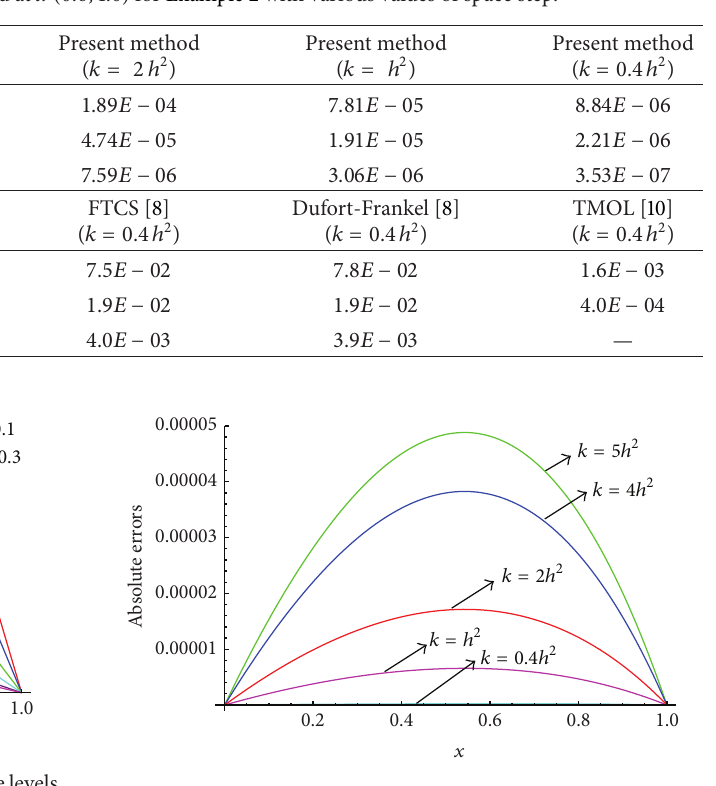
Figure5:Absoluteerrorsofnumericalvaluesat 𝑇 = 1 forExample 3 with ℎ = 0.01 and different time step